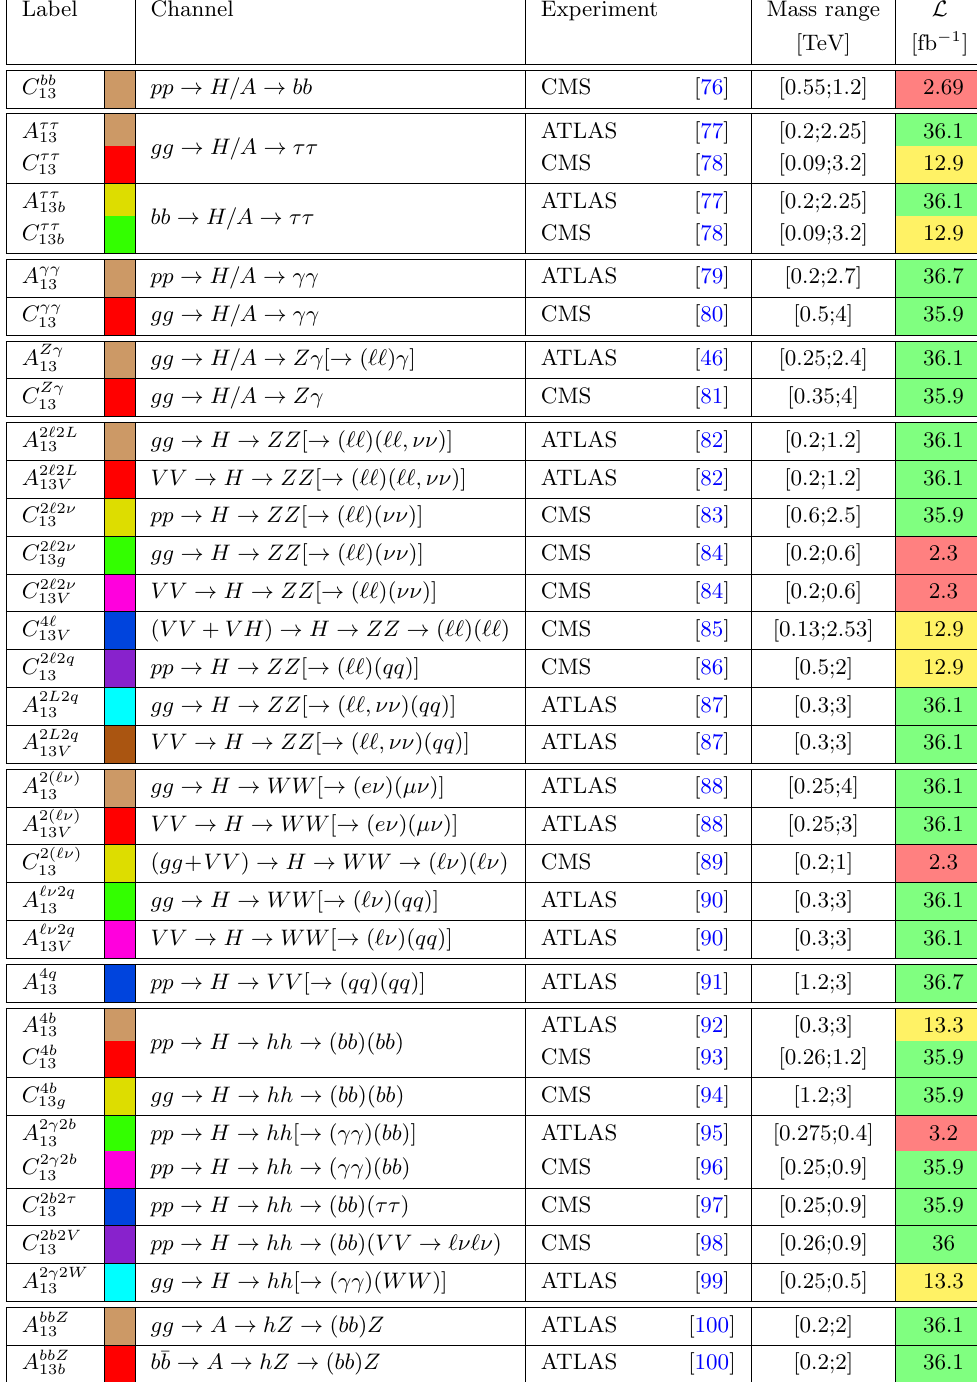
Table 6 . List of the available neutral heavy Higgs searches from LHC Run 2 relevant for the 2HDM. For an explanation, see the description below table 5. In the last column, we additionally highlight an underlying integrated luminosity of around 3, 13 or 36 fb (cid:0) 1 in red, yellow or green,